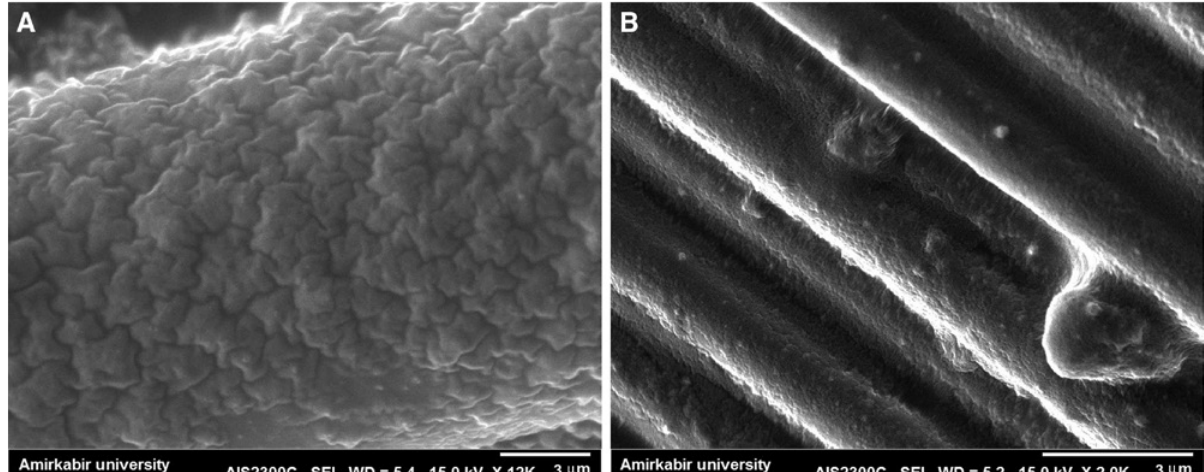
samples with ethanol dilution to scale of (A) 3 µm and (B) 30 µm. Figure 7: Kevlar-SiO 2